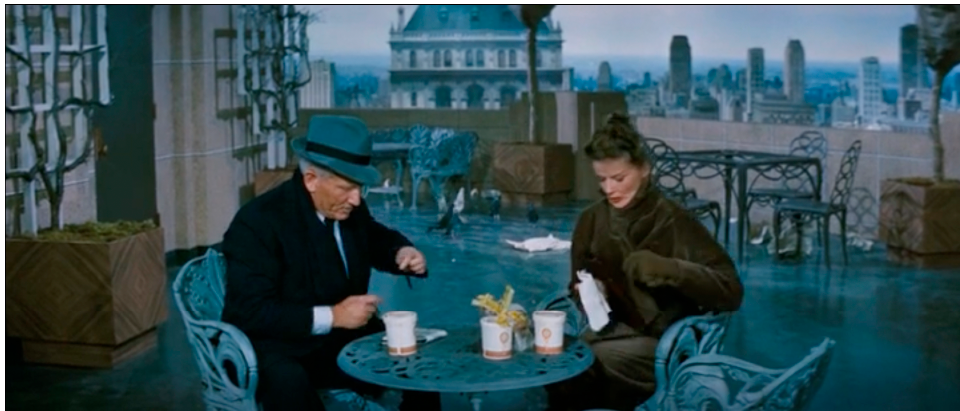
Figure 3. Bunny and Richard eat lunch on the roof